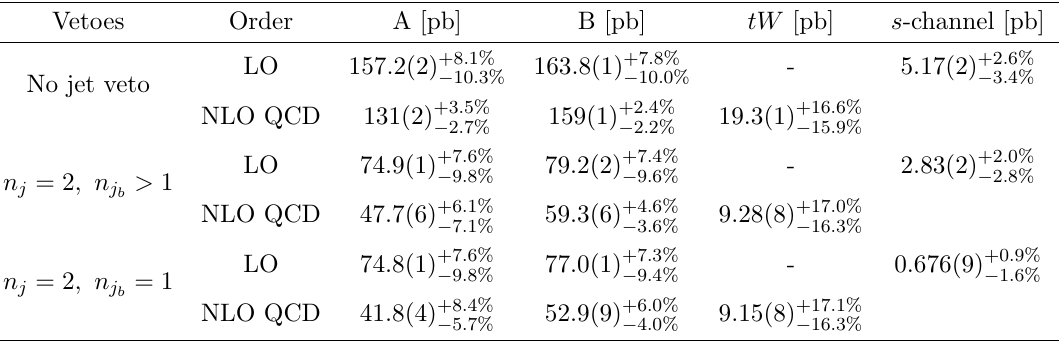
Table 6 . Comparison between approximations A and B applying subsequent jet